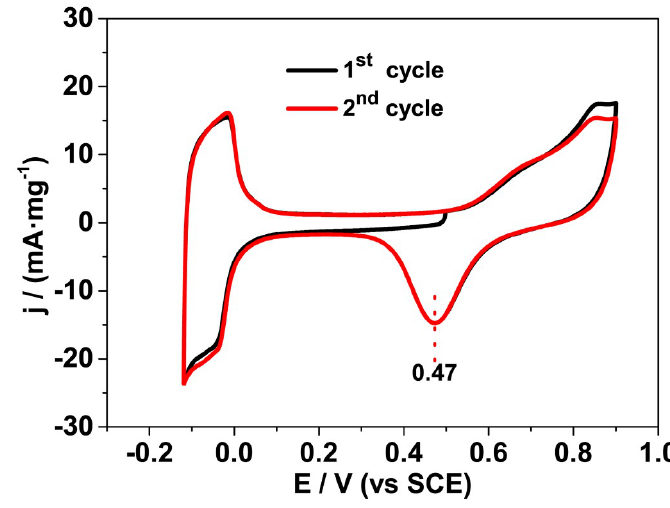
Figure 4. ( a ) X-ray photoelectron spectroscopy (XPS) Pd 3d spectra of P25@Pd core-shell catalyst. Circle symbols are experimental data. Pd 0 peaks at 334.9 eV and 340.2 eV, and Pd δ+ peaks at 336.1 eV and 341.4 eV are fitting results. ( b ) XPS Ti 2p spectra of P25@Pd catalyst and P25 support.